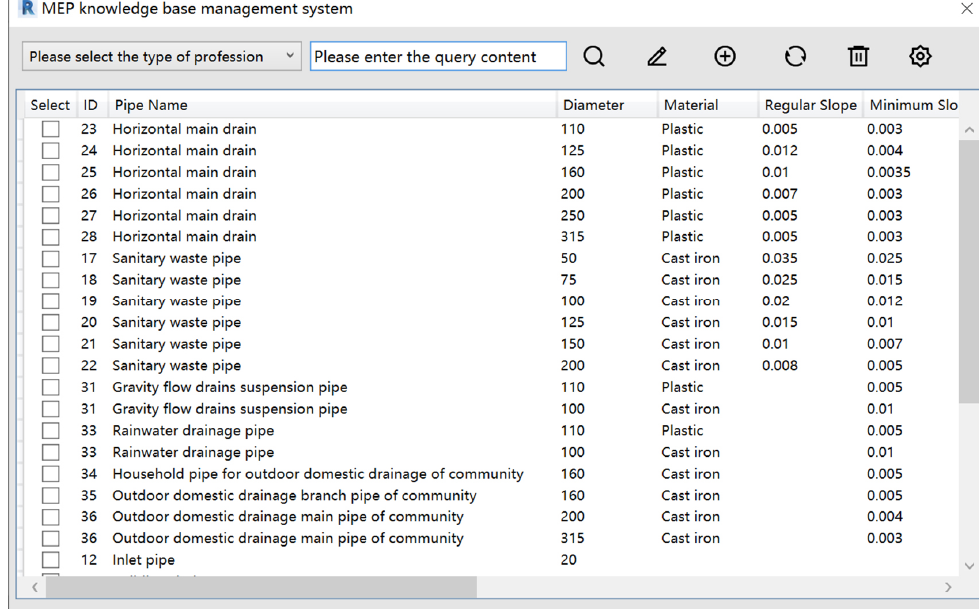
Figure 6. The MEP KBMS